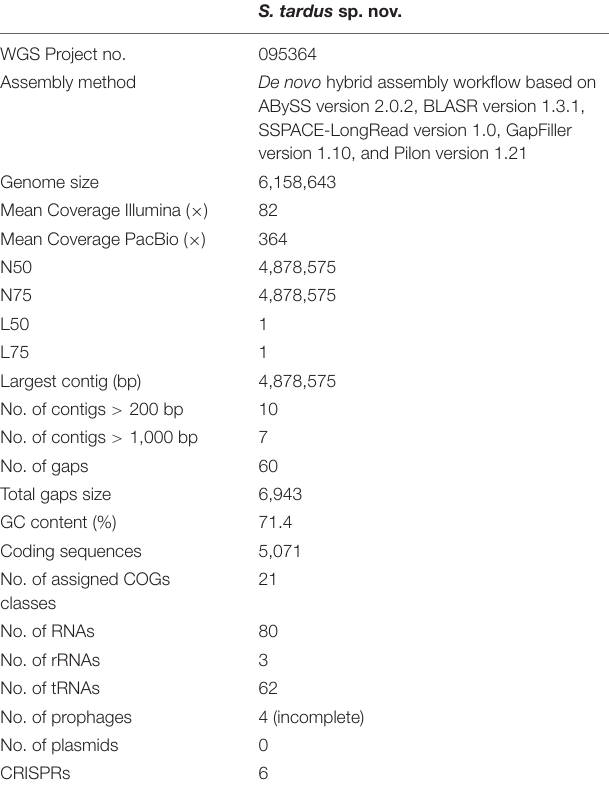
TABLE 3 | Genomic characteristics of S. tardus P38-E01 T . S. tardus sp.